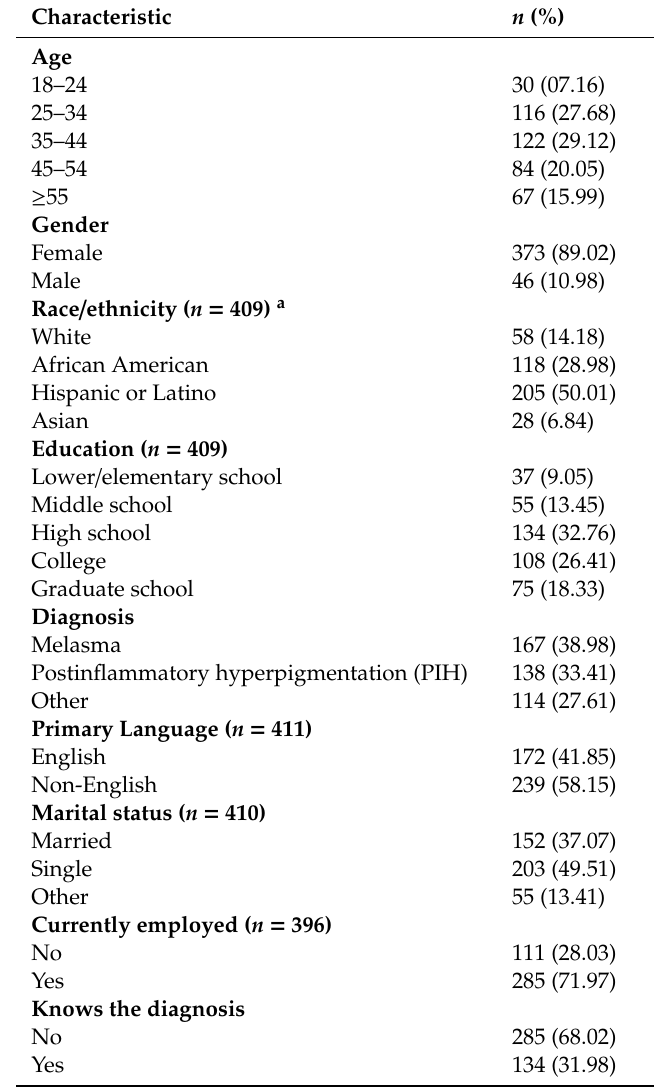
Table 1. Basic demographic characteristic of the study population ( n = 419) a